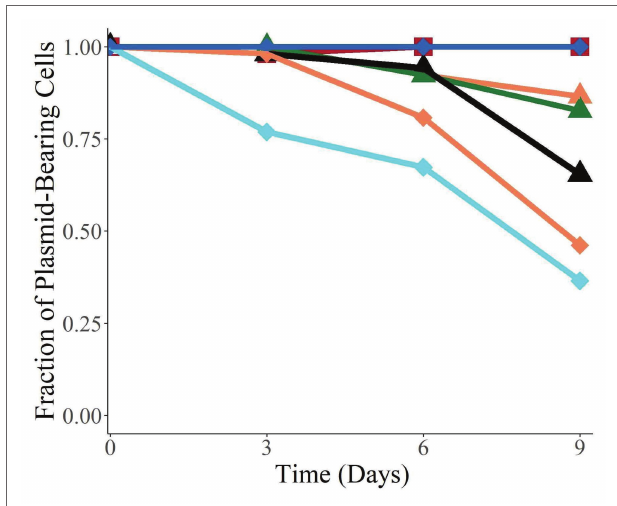
FIGURE 5 | The plasmids were able to persist in their new host over 9 days without selection. Species are coded by shape, and plasmids by color. The proportion of plasmid-carrying cells reported is the median of six replicate cultures. On day 9, the data for E. coli (pALTS31) and S. typhimurium (pALTS33) only represent